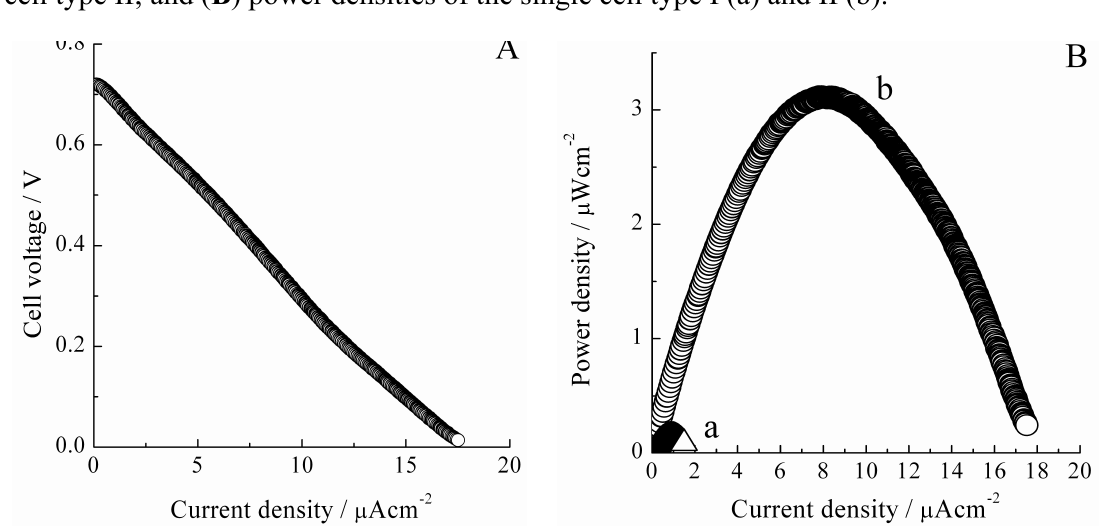
Figure 3. Cell performances of single cell type I and II: ( A ) I - V characteristics of the single cell type II; and ( B ) power densities of the single cell type I (a) and II